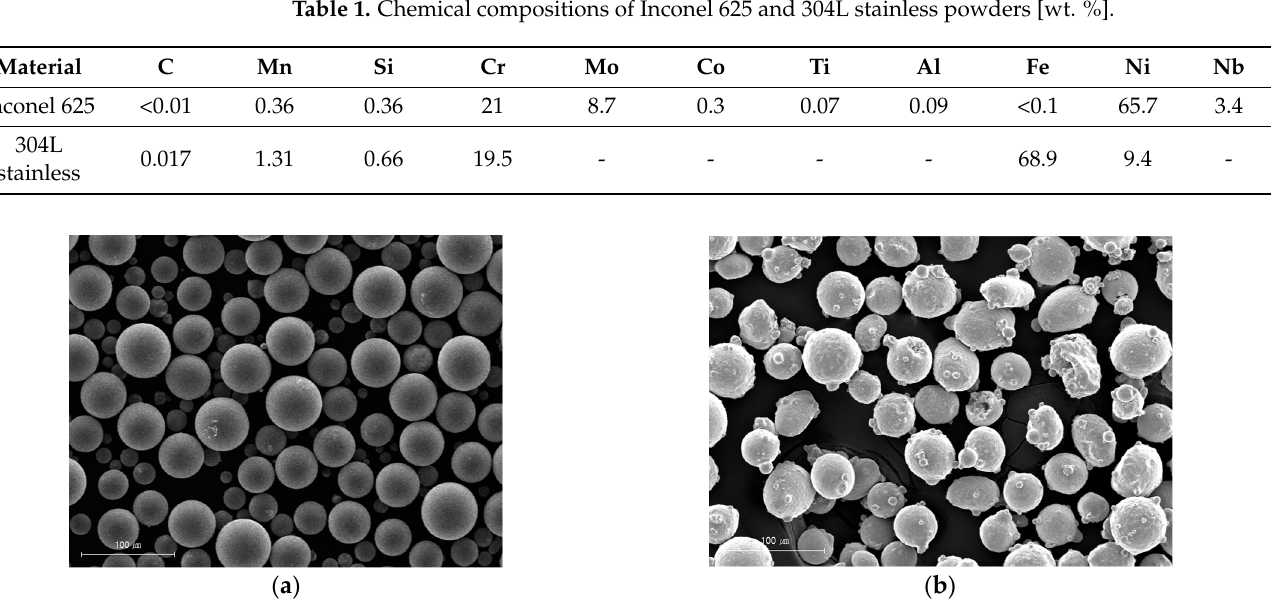
Figure 1. SEM image of the ( a ) Inconel 625 powder and ( b ) 304 L stainless powder. Table 1. Chemical compositions of Inconel 625 and 304L stainless powders [wt. %].